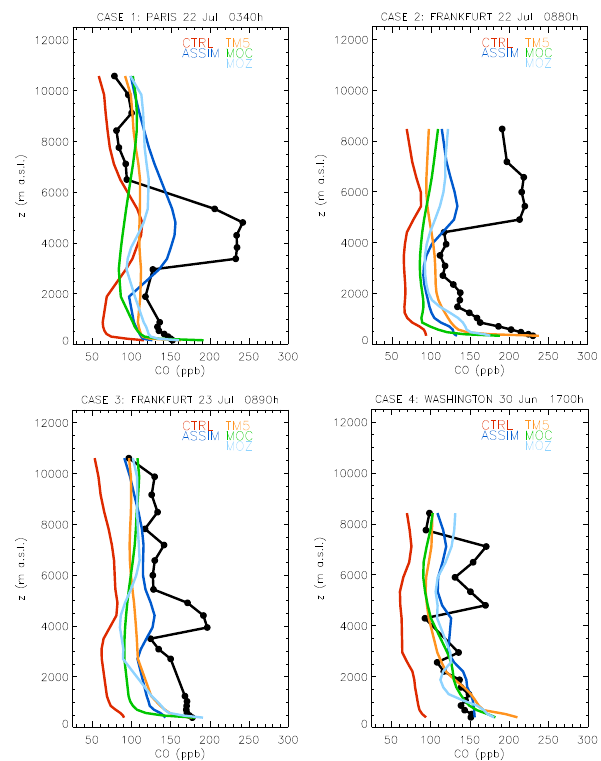
Fig. 11. Vertical profiles of modelled (colored) and observed (filled circles and black lines) CO for each case study.